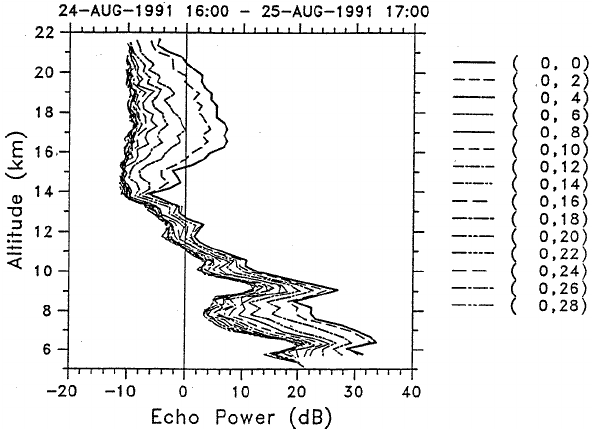
Fig. 1. Vertical power profiles averaged over 1 hour and measured by the 46.5 MHz MU radar in vertical and 15 oblique directions (af- ter Tsuda et al. (1997a). These observations are very typical of the characteristics of aspect sensitivity observed around 50 MHz. How- ever, for shorter time scale averaging, the profiles can exhibit thin echoing layers of vertical echo enhancement, as in Jain et al. (1997) with the Indian MST